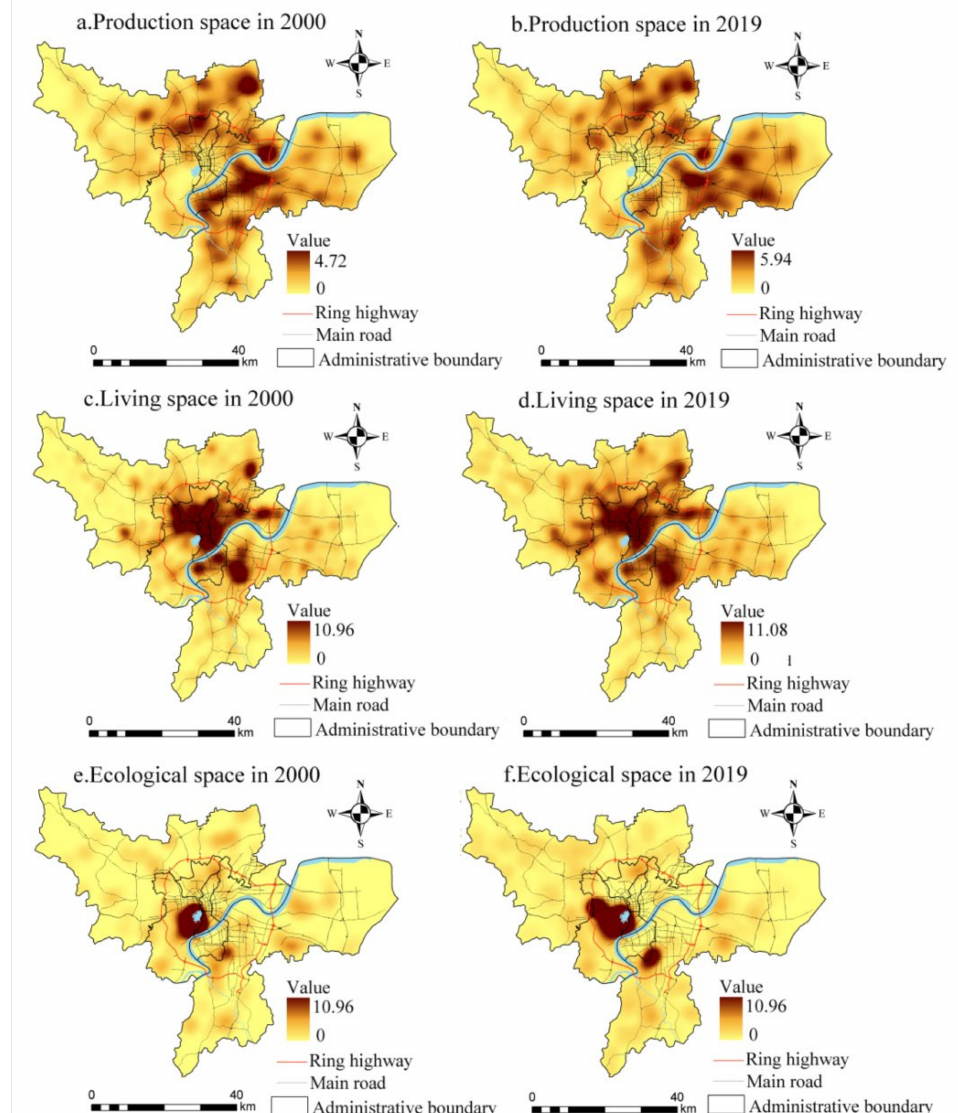
Figure 4. Kernel density maps of production–living–ecological spaces in Hangzhou in 2010 and